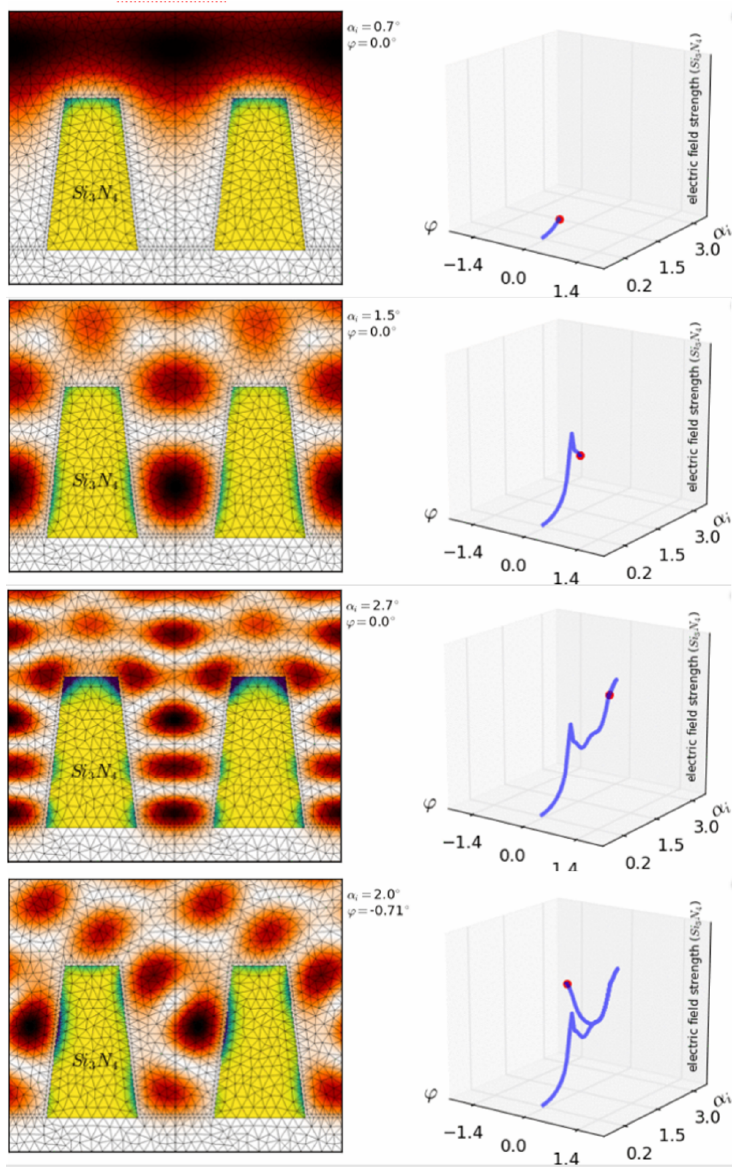
Figure 7. Color-coded intensity of the spatial distribution of the XSW values (left) within a regular nanostructure for four different GIXRF operational parameter combinations of the angle of incidence α i and of the azimuthal angle φ between the nanostructure’s main orientation and the incident beam direction. With respect to nanomaterial development and quality management applications in the semiconductor industry, it is also valuable to take advantage of the optical equivalence